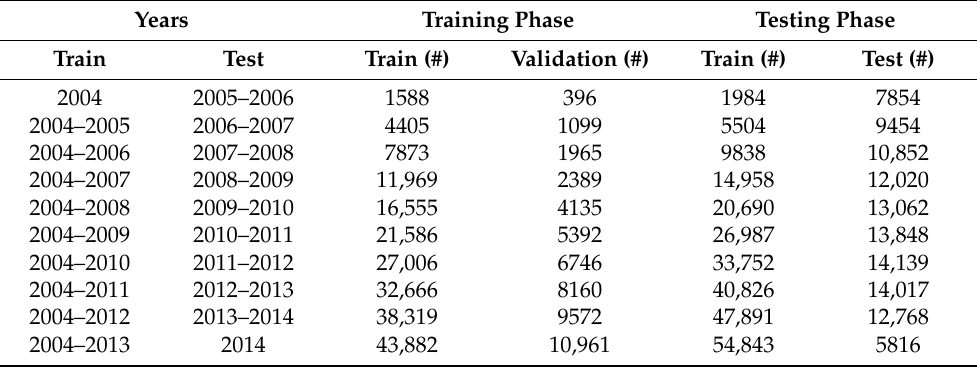
Figure 1. Chart for the general strategy for model development and test. Top-line on the chart: each new year X (right-most position on the x-axis), an updated model can be trained on the already ready gold-standard data, i.e., up to the previous two years (blue), and used to predict the following two years X − 1 and X (white). Middle-line on the chart: the following year X + 1, a second, updated prediction (yellow) can be made on one of the years of tested data (X − 1) with the previous model. Bottom-line on the chart: in the second next year X + 2 the gold standard is supposed to be ready for that year X − 1, becoming a new training data (blue). The model can provide an updated prediction for the year X and a new prediction for the years X + 1 and X + 2 (i.e., the current one “just ended”). Table 2. Cases in each set of the models trained. All child records for a given year represent a case, i.e., the same child in distinct years represents distinct and independent cases. Each row reports datasets for the training, validation, and test of a